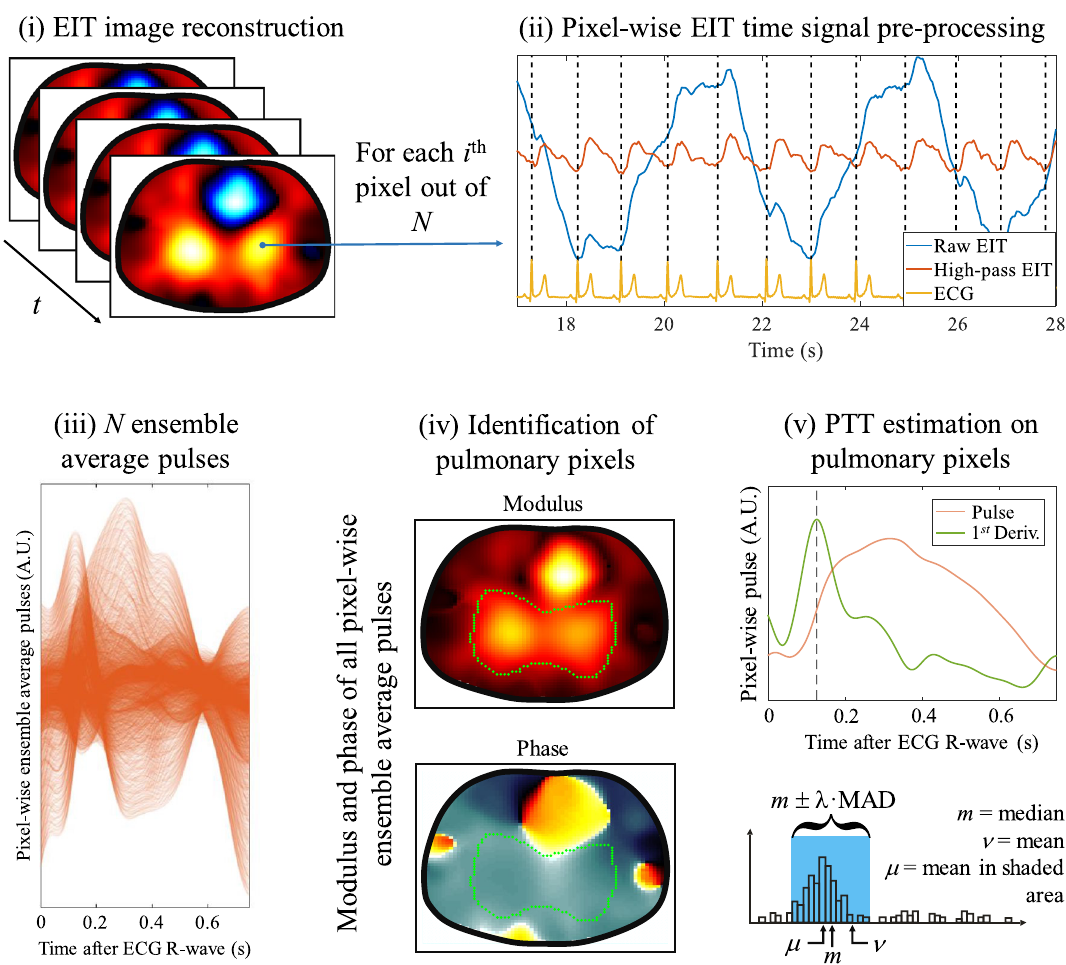
Figure 1. Estimation of the pulmonary PTT (as the pulse arrival time) from ECG and EIT data. After ( i ) EIT image reconstruction, each pixel-wise EIT time signal is ( ii ) high-pass filtered and summarized to one representative pulse through ECG-gated ensemble averaging, resulting in ( iii ) N cardio-synchronous ensemble average pulses for the N pixels of the EIT image sequence. ( iv ) The modulus and phase of all N ensemble average pulses is calculated and a pulmonary region of interest of M pixels is obtained by finding all pixels with significant pulsatile amplitude showing coherent phase with the average cardiac-related EIT signal. ( v ) For each of the M pulmonary pixels, the PTT is estimated using the maximum of its first time derivative. Finally, the global pulmonary PTT is obtained by averaging the PTT values of all M pulmonary pixels after outlier rejection using the MAD method. ECG electrocardiography, EIT electrical impedance tomography, PTT pulse transit time, MAD median absolute